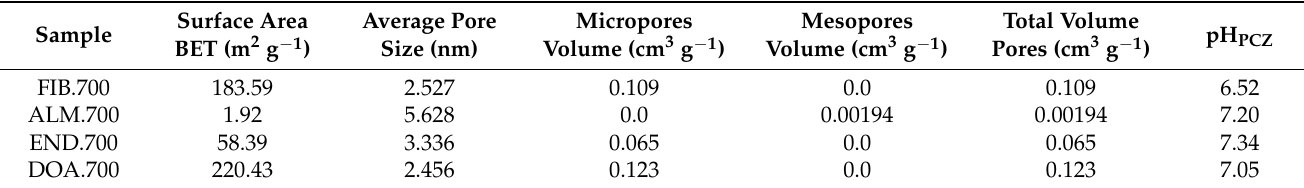
Table 2. Textural characteristics of the buti á -based